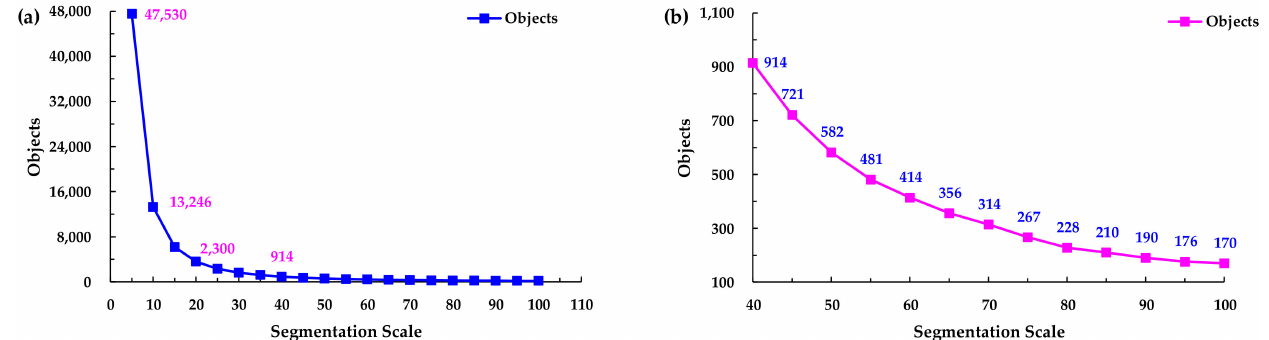
Figure 3. Scale versus number of objects. ( a ) General view of segmentation scale 5–100; ( b ) Local enlarged view of segmentation scale